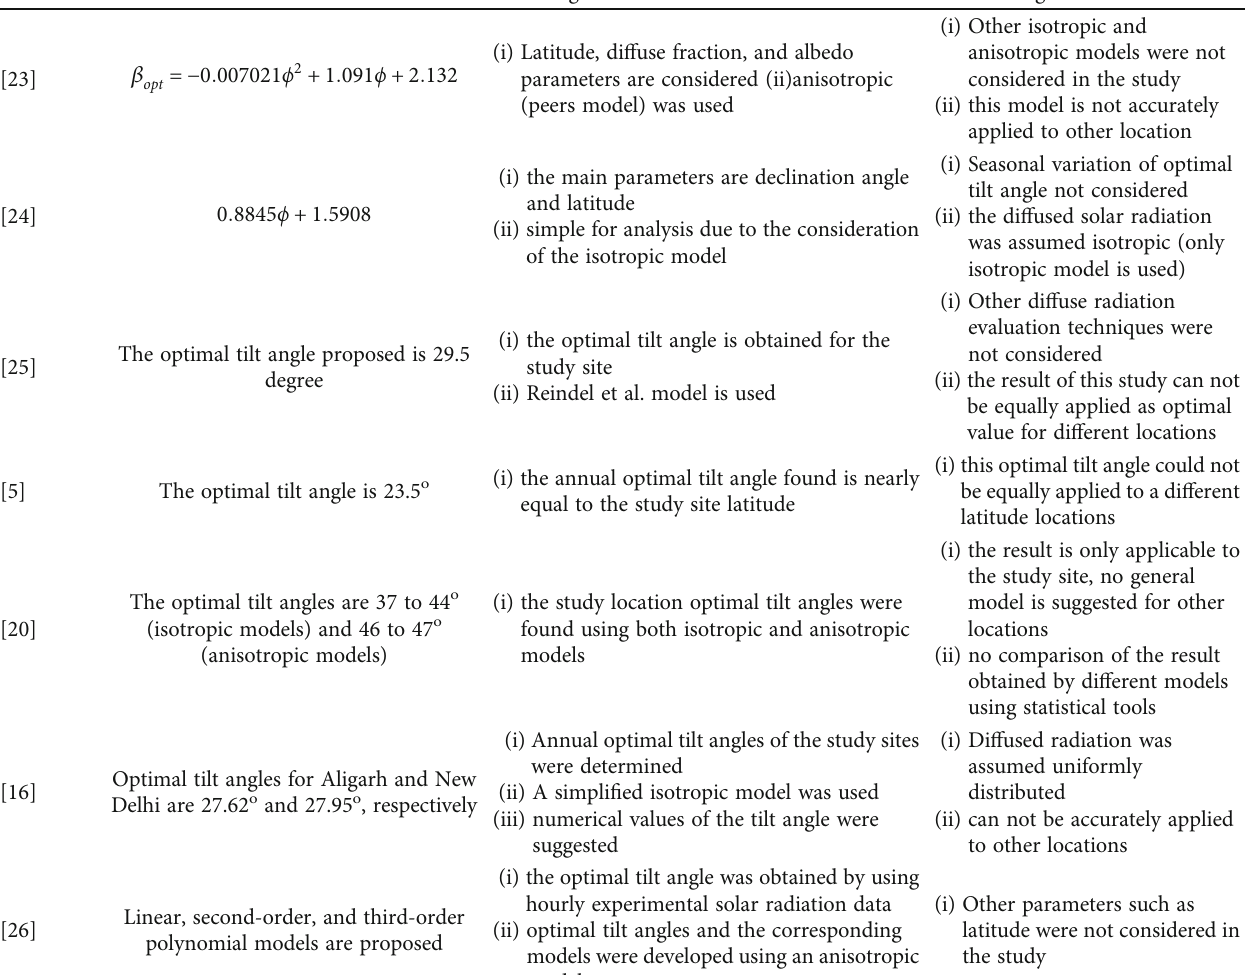
Table 1: Summary of related previous